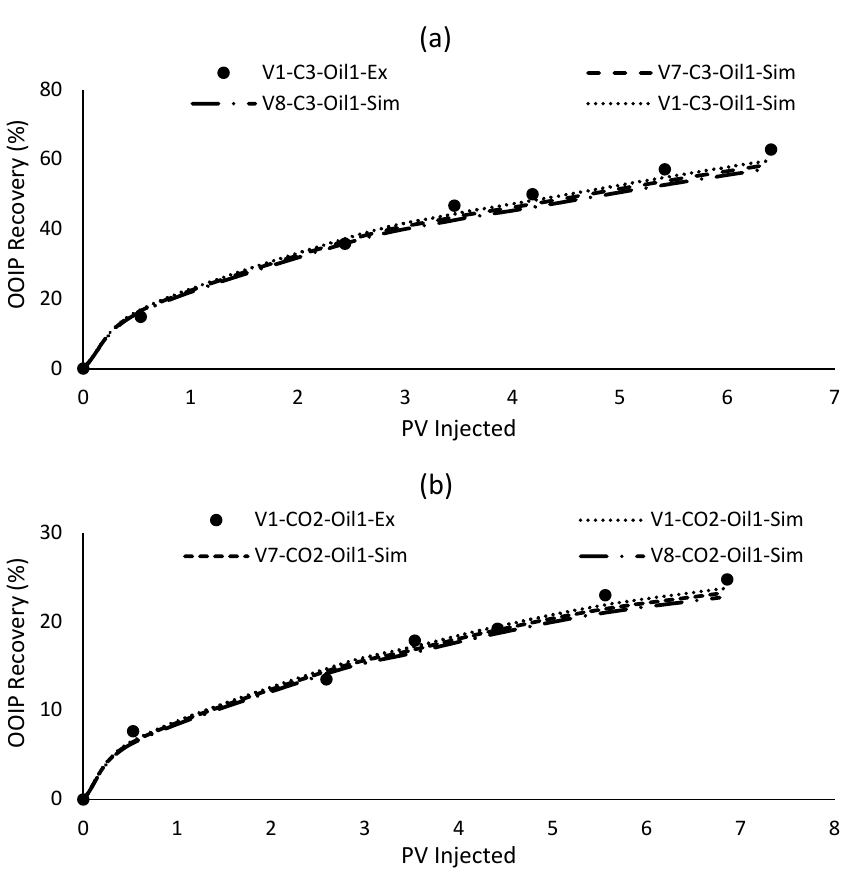
Figure 19. The effect of fracture position on the recovery factors in conventional VAPEX and patterns V1, V7, and V8 using propane ( a ) and carbon dioxide ( b ).